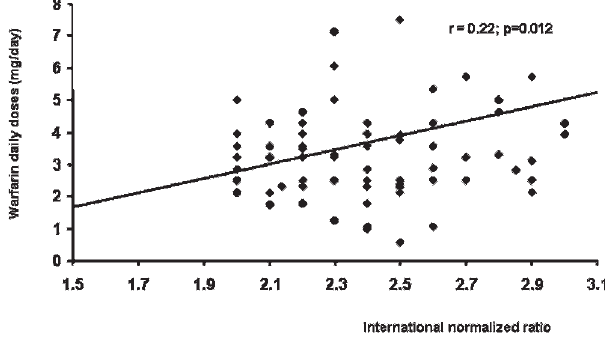
Figure 1 - A simple linear regression analysis comparing the daily warfarin dose and the international normalized ratio is pre-